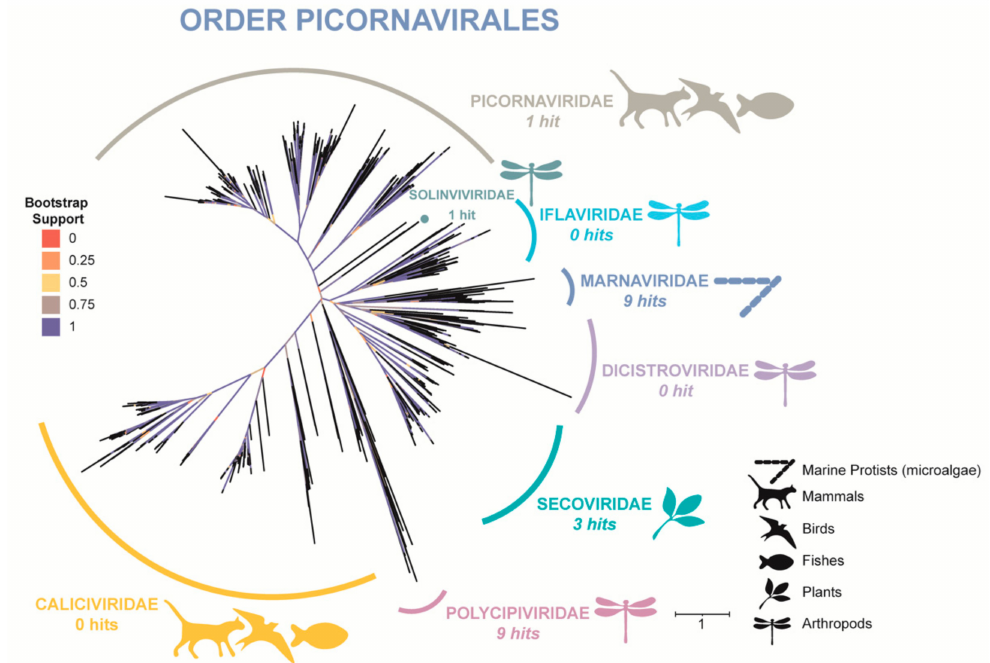
Figure 5. Maximum-likelihood phylogeny of RNA-dependent RNA polymerase (RdRp) of order Picornavirales based on RdRp sequences retrieved from metagenomic assembly results and the NCBI GenBank database. Bootstrap support is indicated by color, and number of RdRp hits extracted from our study are indicated alongside family